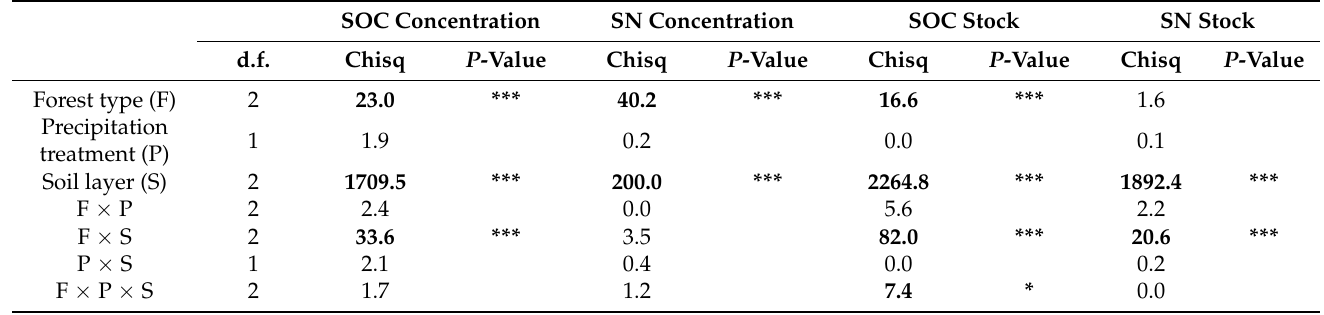
Table 3. Effects of forest type ( P. halepensis , Q. ilex and Q. pubescens ), precipitation treatment (natural or amplified drought), soil layer (organic or organo–mineral) and their interactions on SOC and SN concentrations and stocks. Chi-square values and associated P -values (* for P < 0.05 and *** for P < 0.001) are indicated. Significant values are indicated in